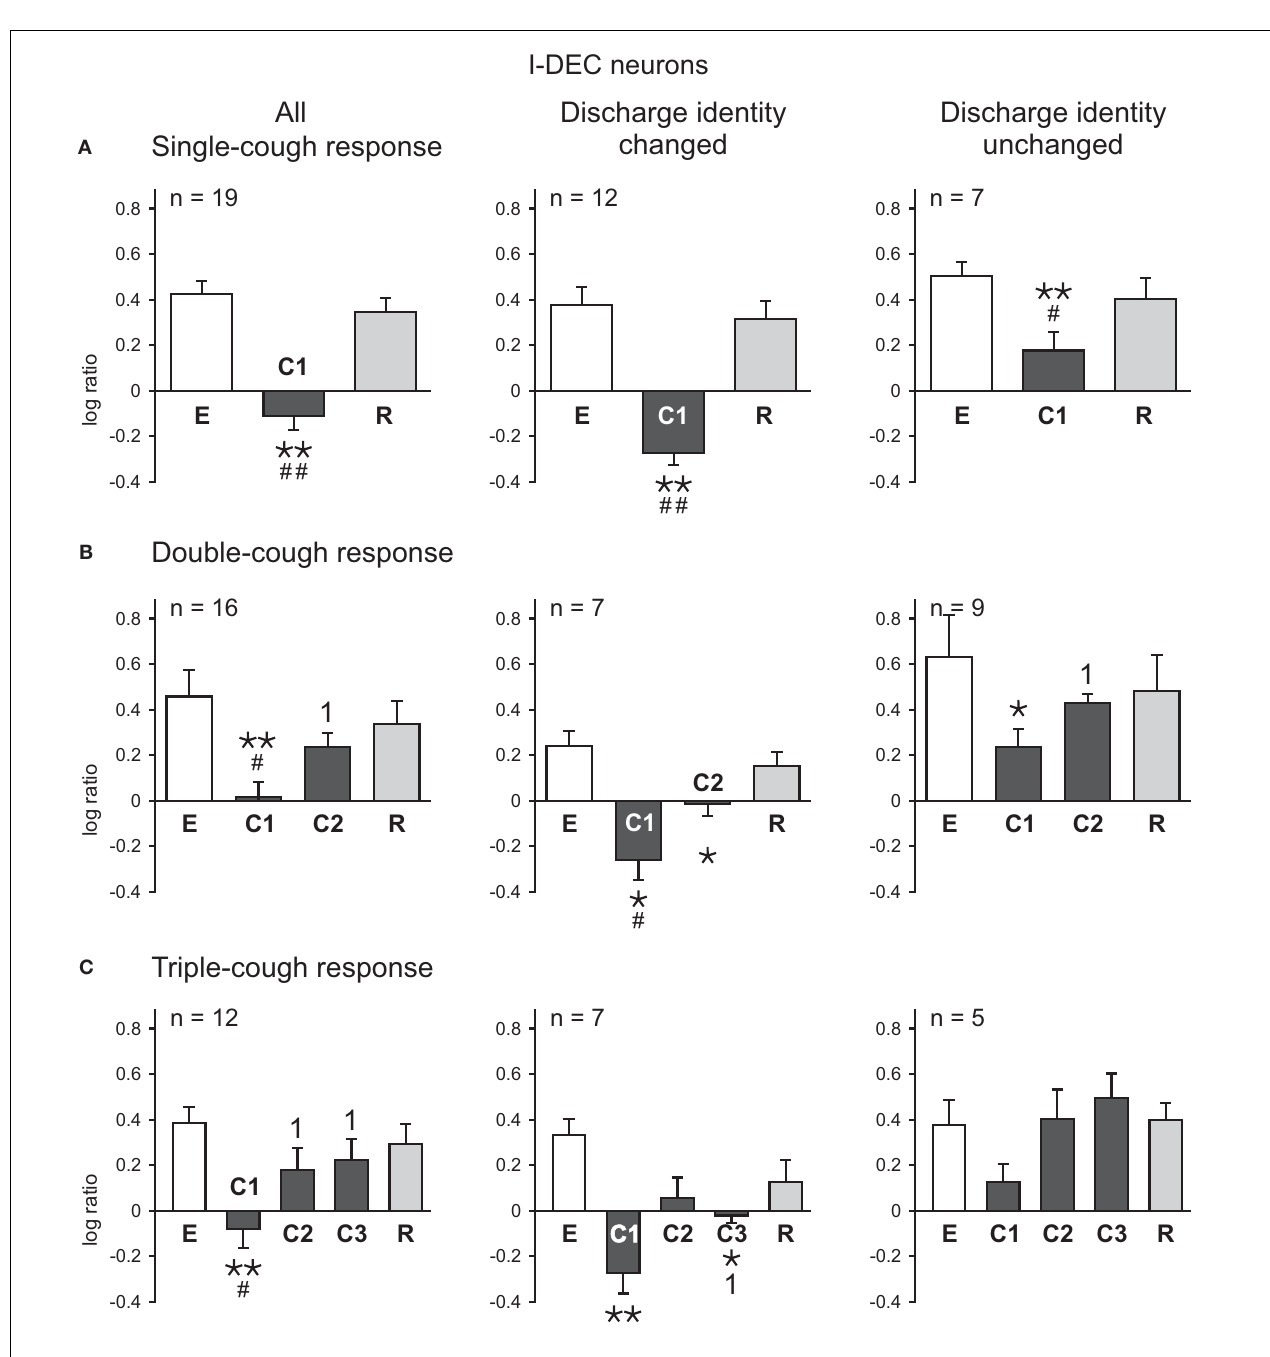
from E; #, significantly different from R; 1, significantly different from C1. P -values are indicated by one ( p < 0.02) or two ( p < 0.001) symbols. Number of neurons ( n ) analyzed for each cough episode type is indicated on the plots. Some neurons were evaluated for more than one type of cough response. Error bars indicate the standard error of the